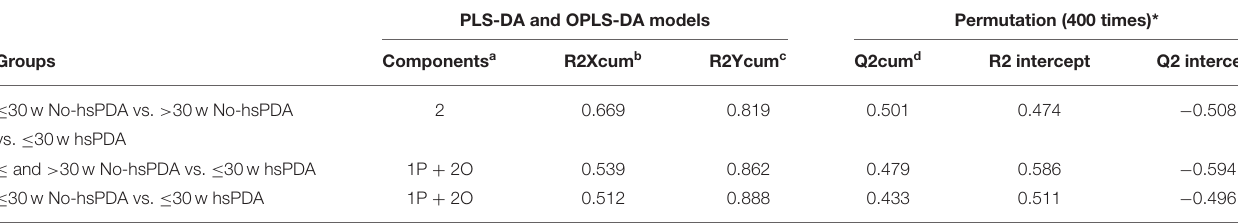
TABLE 4 | Parameters for PLS-DA and OPLS-DA models.